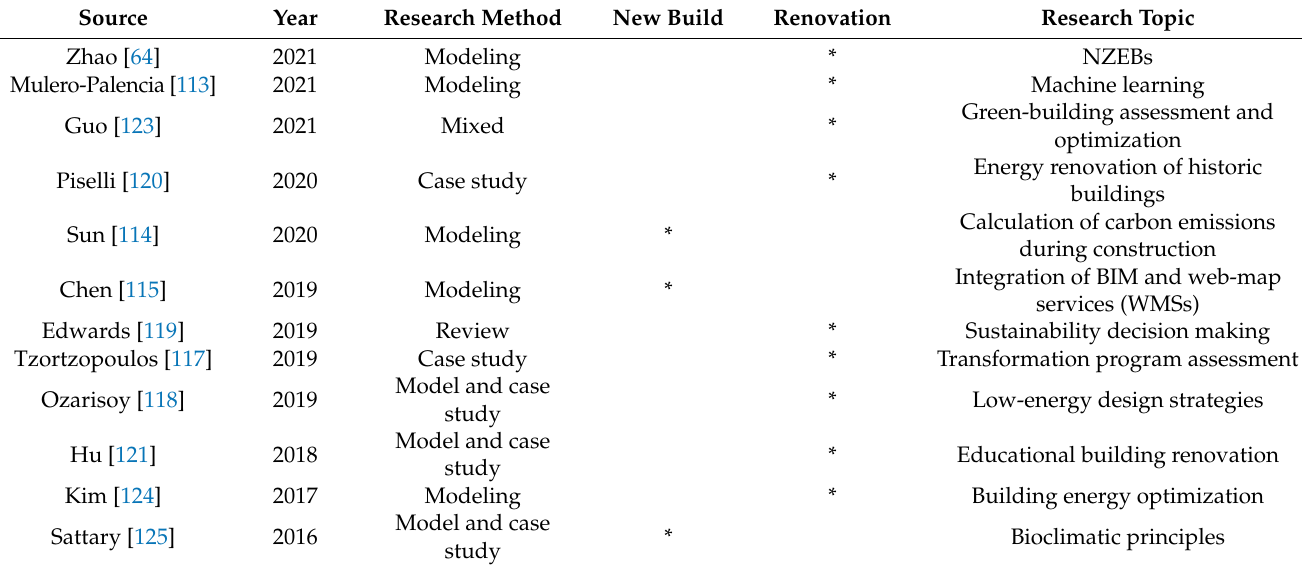
Table 3. The role of BIM in the construction stage in terms of carbon emissions (generated by the authors).